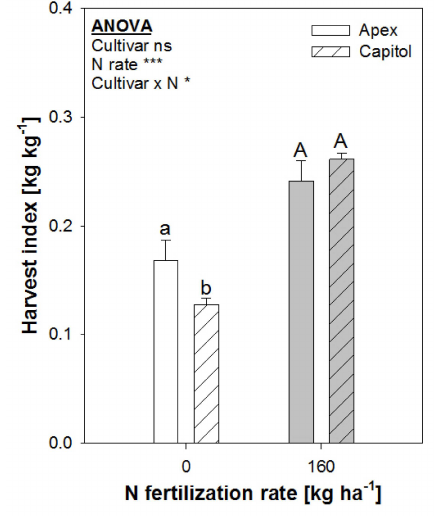
Figure 3. Harvest index at maturity of the winter oilseed-rape line-cultivars Apex and Capitol as affected by the N fertilization rate (N0 and N160). Different lower case and upper case letters on top of the columns indicate differences between the cultivars within the N fertilizer rates at p < 0.05. ANOVA: * and *** indicate significant differences at p < 0.05 and p < 0.001, respectively. ns = non-significant. The error bars represent the standard deviations of the means ( n =